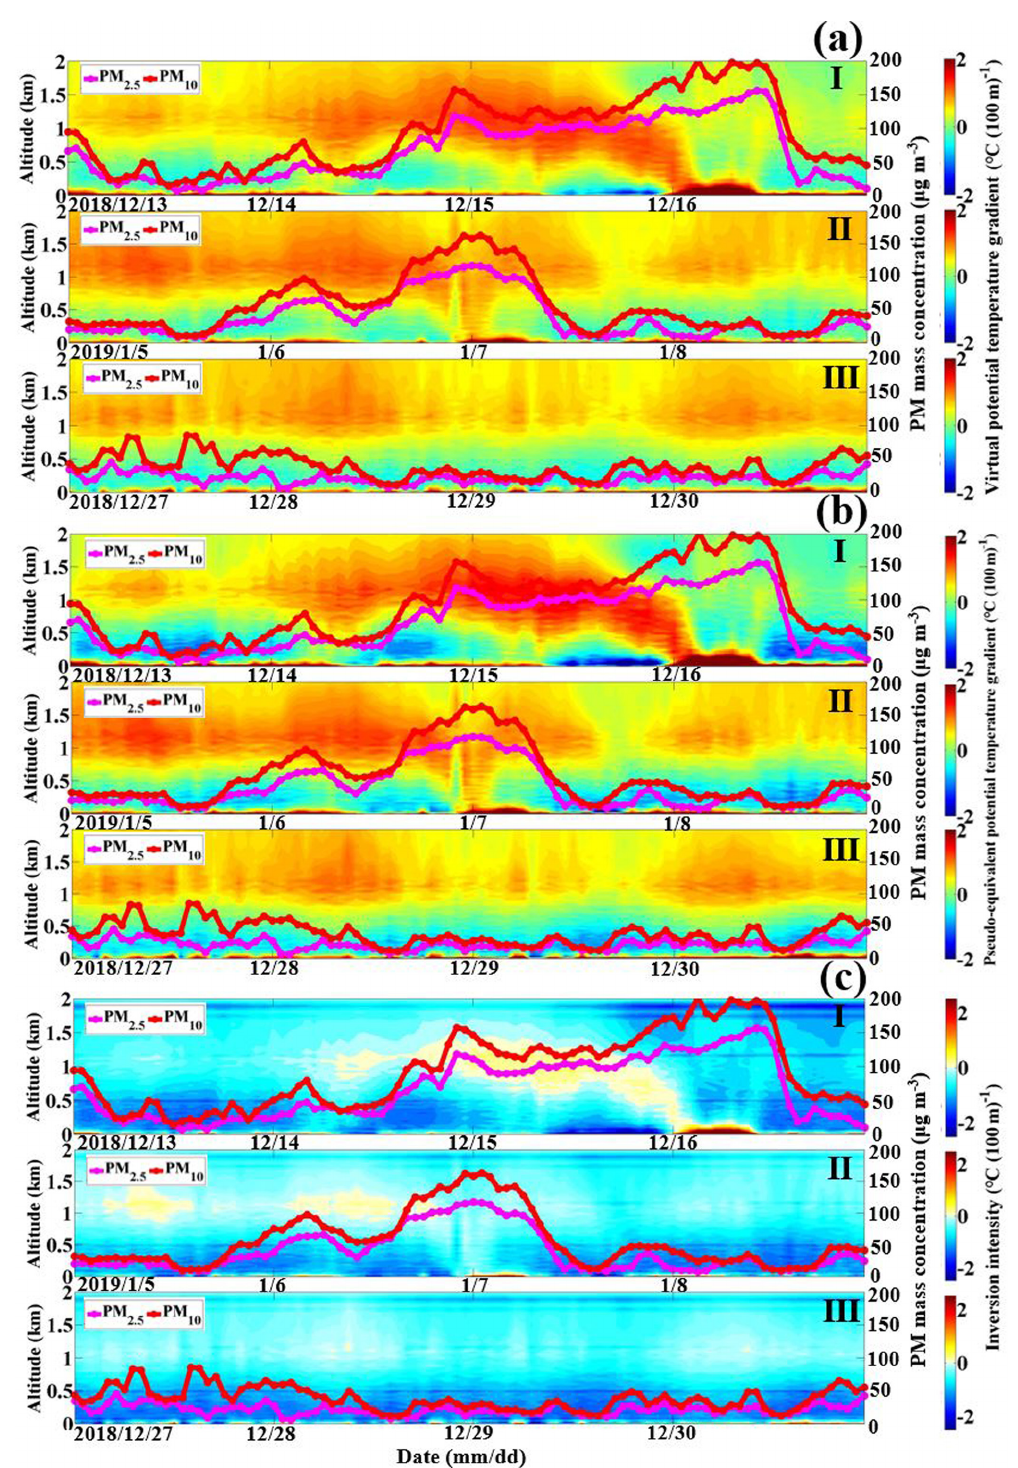
Figure 2. Temporal variation in the vertical profiles of (a) the virtual-potential-temperature gradient ( ∂θ v /∂z ), (b) pseudo-equivalent- potential-temperature gradient ( ∂θ se /∂z ) and (c) temperature inversion phenomenon (shaded colors: inversion intensity) during the typical haze pollution episodes of I (13–16 December 2018) and II (5–8 January 2019) as well as the typical clean period of III (27–30 December